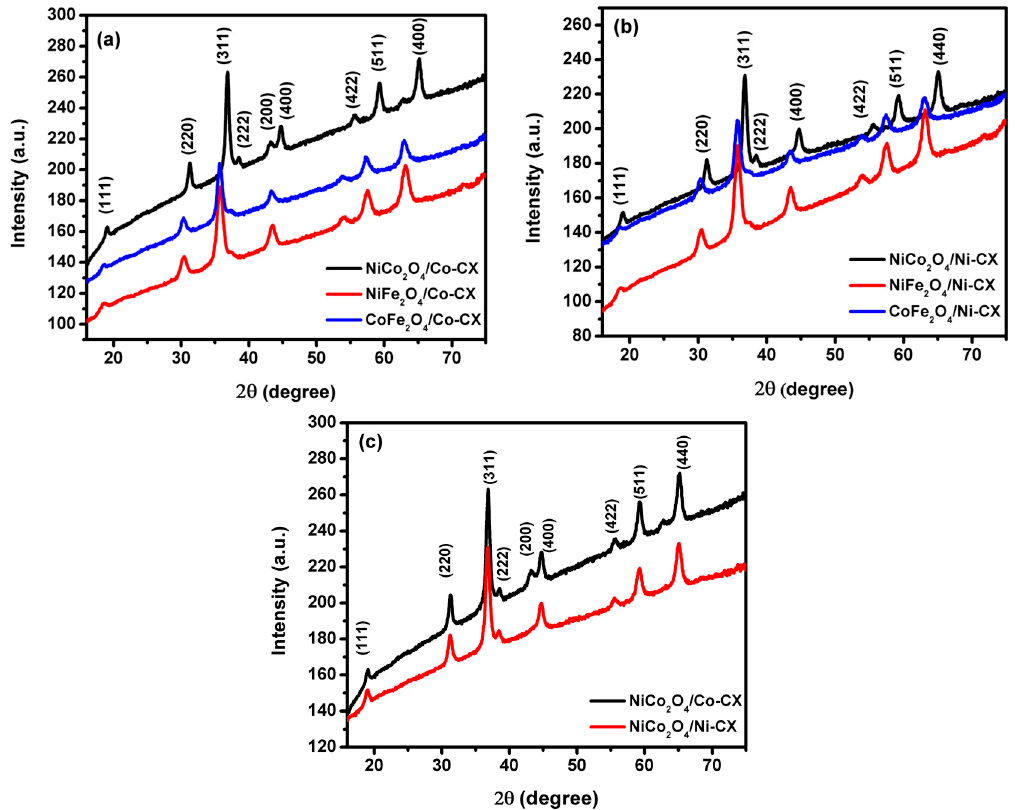
Figure 2. The XRD patterns for ( a ) bimetal oxides doped cobalt xerogels, ( b ) bimetal oxides doped nickel xerogels and ( c ) nickel cobaltite doped cobalt and nickel carbon xerogels.